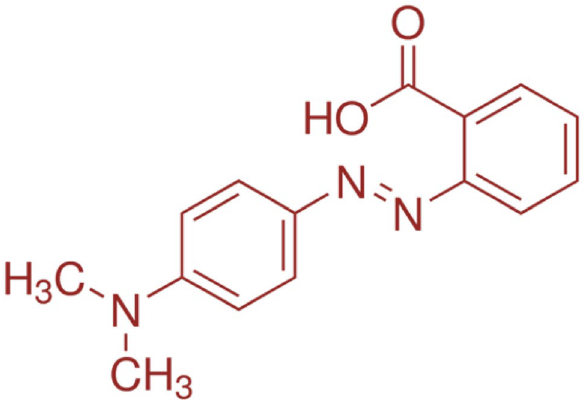
Figure 1. Formula of methyl red (Azo dye).